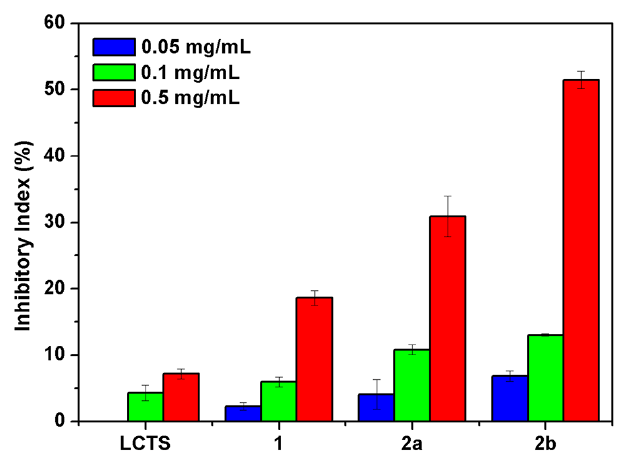
Figure 9. The antifungal activity of chitosan and chitosan derivatives against F. oxysporum .